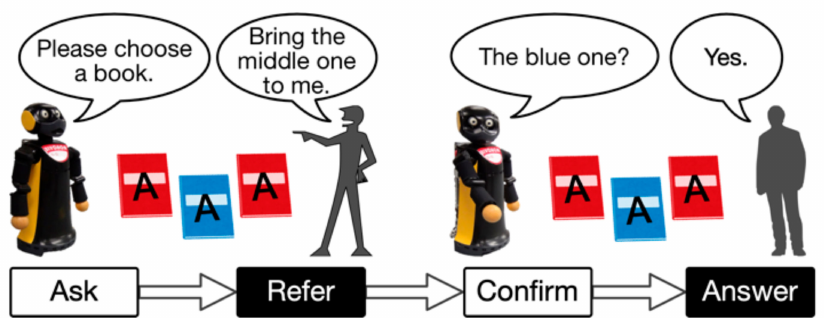
Figure 2. Example of the object reference conversation using the implicit alignment strategy.